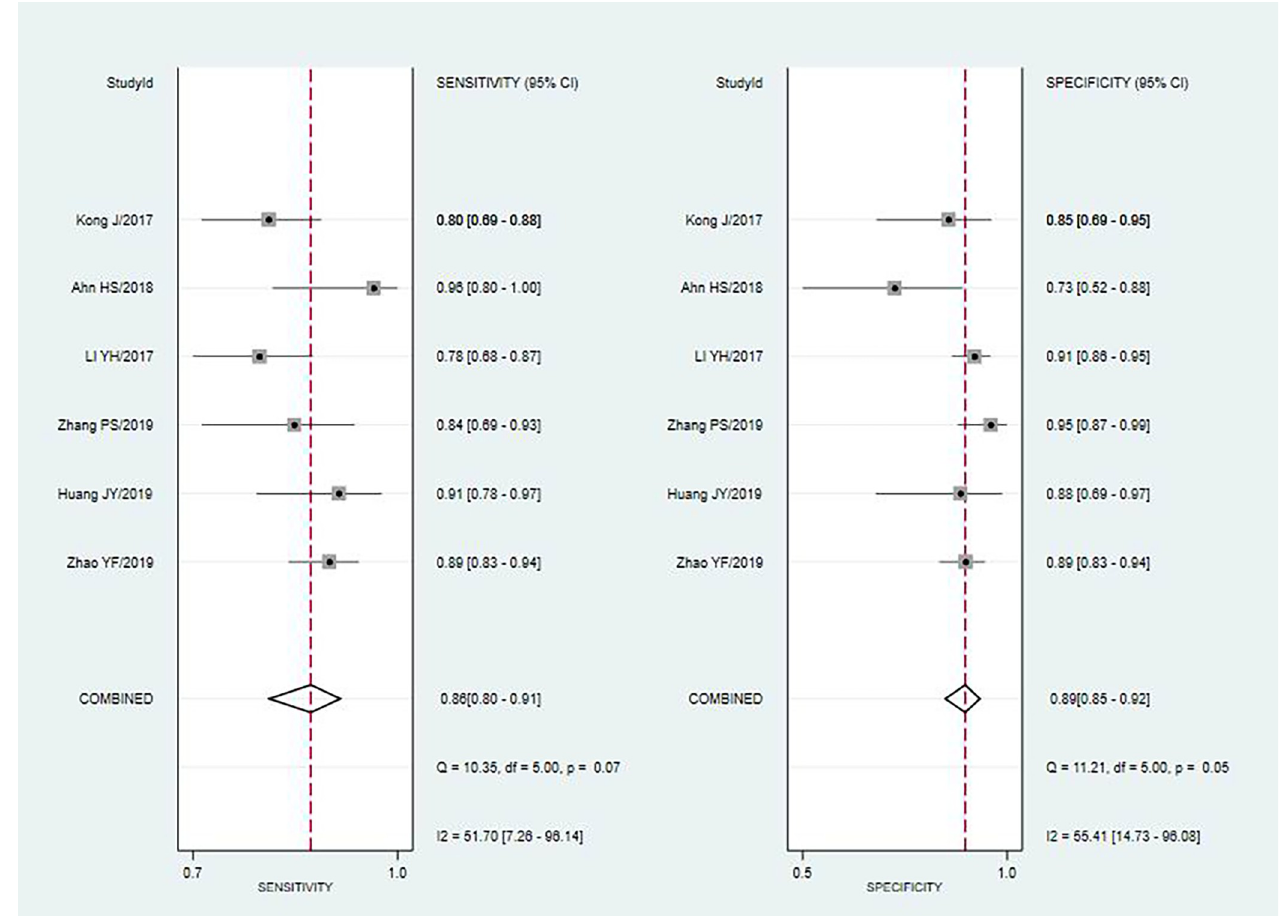
Fig 3. Forest plots for the accuracy of TI-RADS combined with SMI for the diagnosis of thyroid nodules.